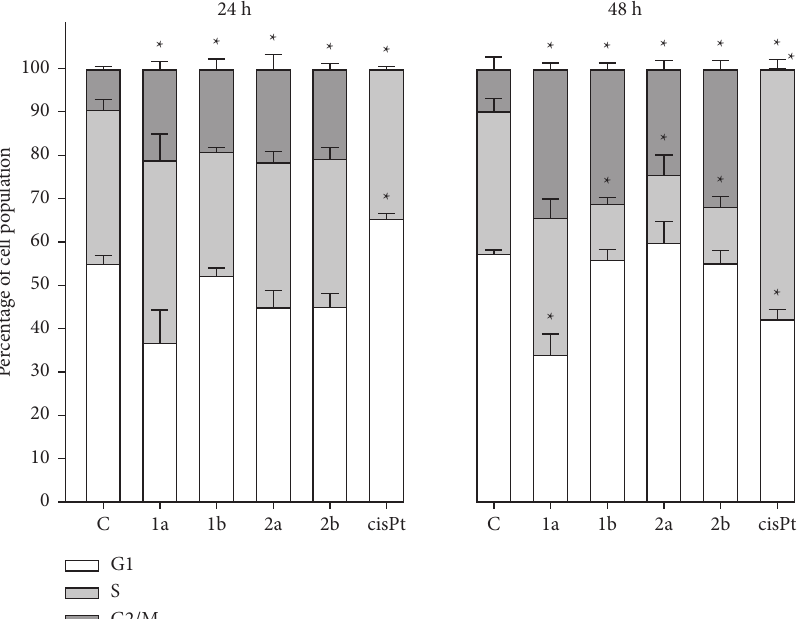
Figure 9: Effect of Pt-alkylpyrazole complexes on cell cycle distribution: quantitative analysis of cell cycle phases proportion. MDA-MB-231cells wereeitheruntreatedortreatedwithequitoxicconcentrations(IC 50,72h )ofinvestigatedPtcomplexesorcisplatinfor24hor48h.Datarepresentthe mean ( ± SD) of three independent experiments; stars indicate significant difference from control, untreated cells ( p <